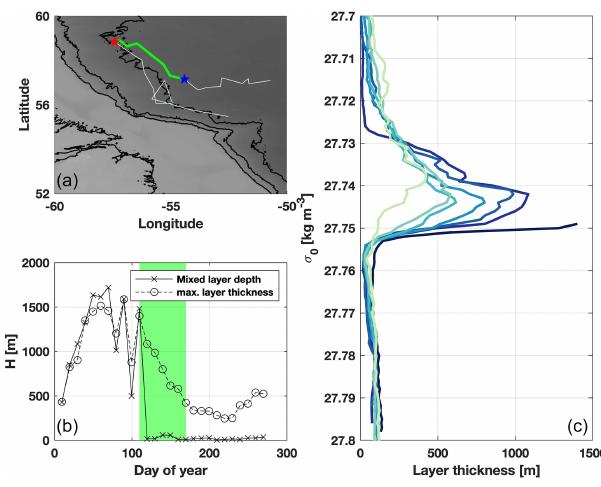
Figure 3. Example of Argo data used to track LSW input into the boundary current after convection from float ID 6902589. (a) Tra- jectory showing latest deep mixed layer measurement (blue star) and location of entry into boundary current (red star). Thick green line highlights the part of the trajectory from LSW formation to crossing the 3000m isobath. (b) Time series of mixed layer depth and maximum layer thickness, with green shading highlighting the time from convection in the interior to entering the boundary cur- rent. (c) Consecutive profiles of layer thickness in density space, going from convection (dark blue) to input into boundary current (light